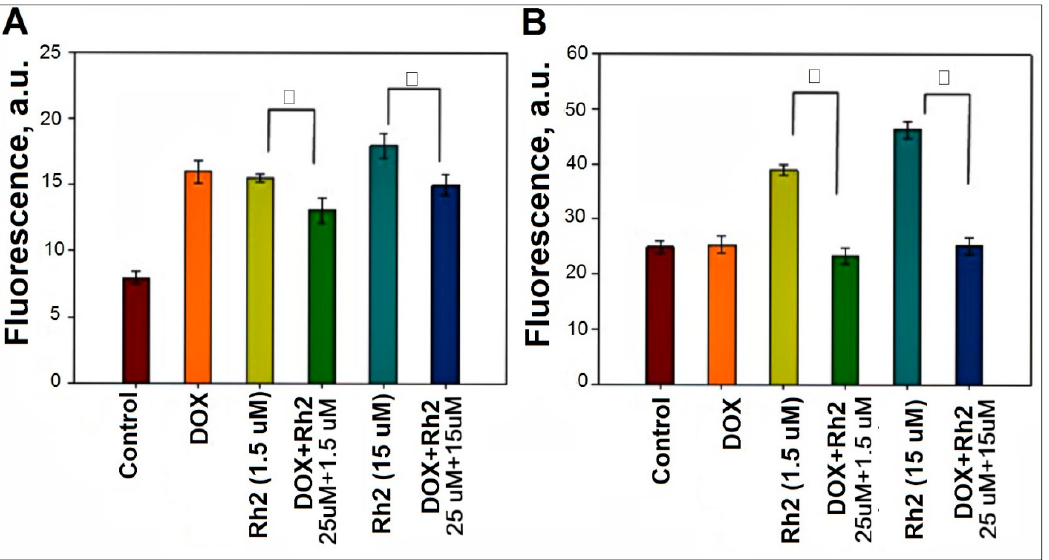
Figure 5. Rh2-induced ROS production assayed by DCFDA fluorescence 3 h after drug treatment. ( A ) adenocarcinoma cells and ( B ) splenocytes were treated with DOX (25 μ M) and Rh2 (1.5 and 15 μ M). The cell density of adenocarcinoma cells was 20,000 cell/well, and 10,000 cell/well for splenocytes. (N = 6). □ Pairwise comparison as indicated, p < 0.01.